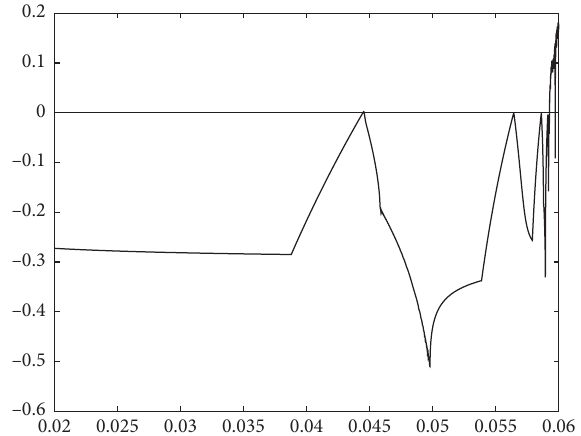
Figure 13: The largest Lyapunov exponent when β